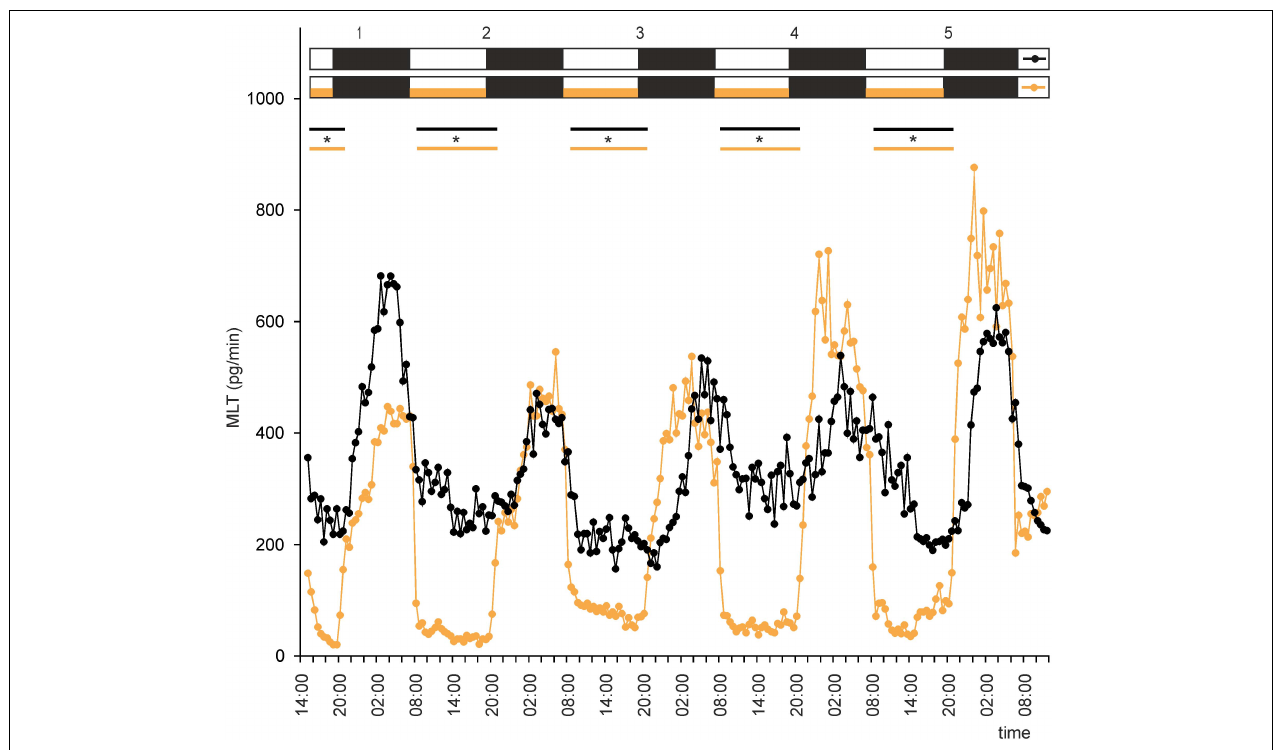
FIGURE 2 | Secretion (means, n = 4) of melatonin (MLT) by goose pineal organs incubated under 12 h of light and 12 h of darkness (LD) for 5 days with the presence of NE during photophase (orange line with circles) and without it (black line with circles). White horizontal bars in upper part of image indicate photophase; black bars indicate scotophase; orange bars indicate period of NE treatment. Parallel lines with asterisks show periods, when the means differ significantly ( p < 0.05) between groups.